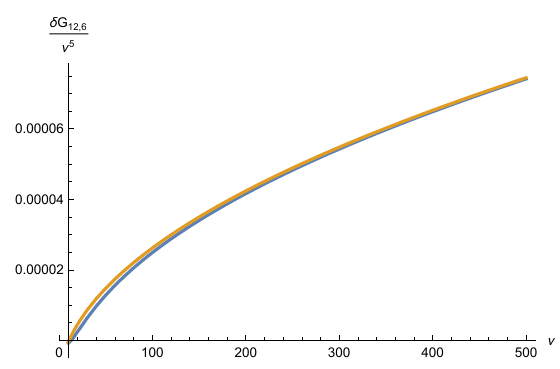
G 12 ; 6 ( (cid:23) ) to probe (cid:23) 5